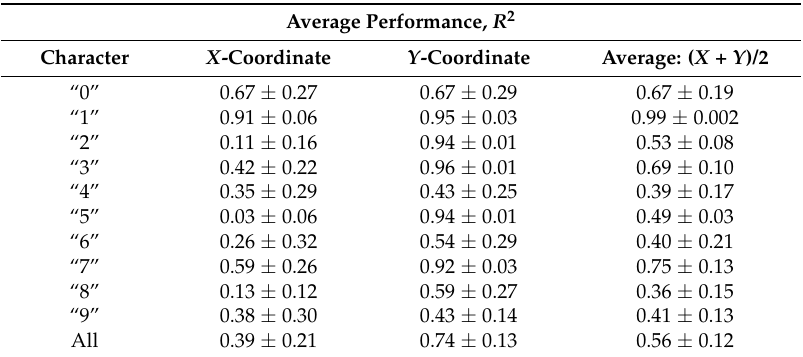
Table 13. Between-group reconstruction performance by the GEP: the average accuracy of each numeric character across the five subjects.